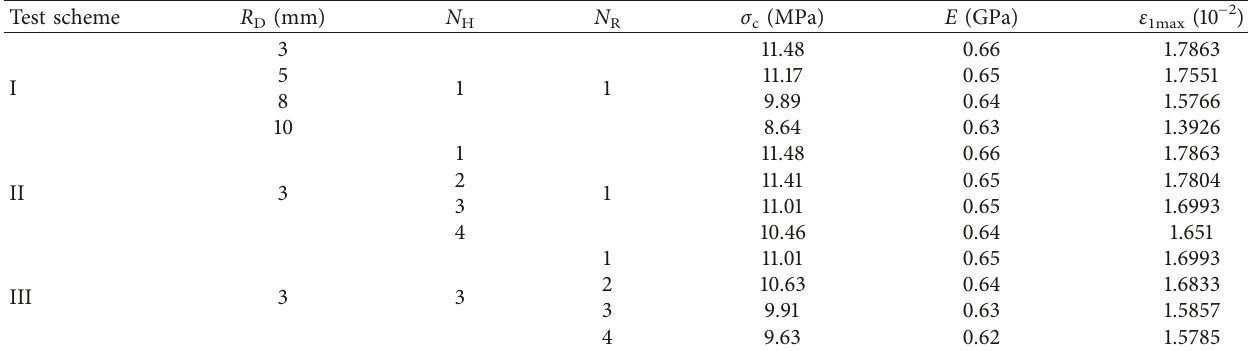
Figure 5: Stress-strain curves of specimens with different drilling arrangements under uniaxial compression. (a) Different drilling di- ameters. (b) Different numbers of drilling holes. (c) Different numbers of drilling rows. Table 4: Mechanical properties of specimens with different drilling